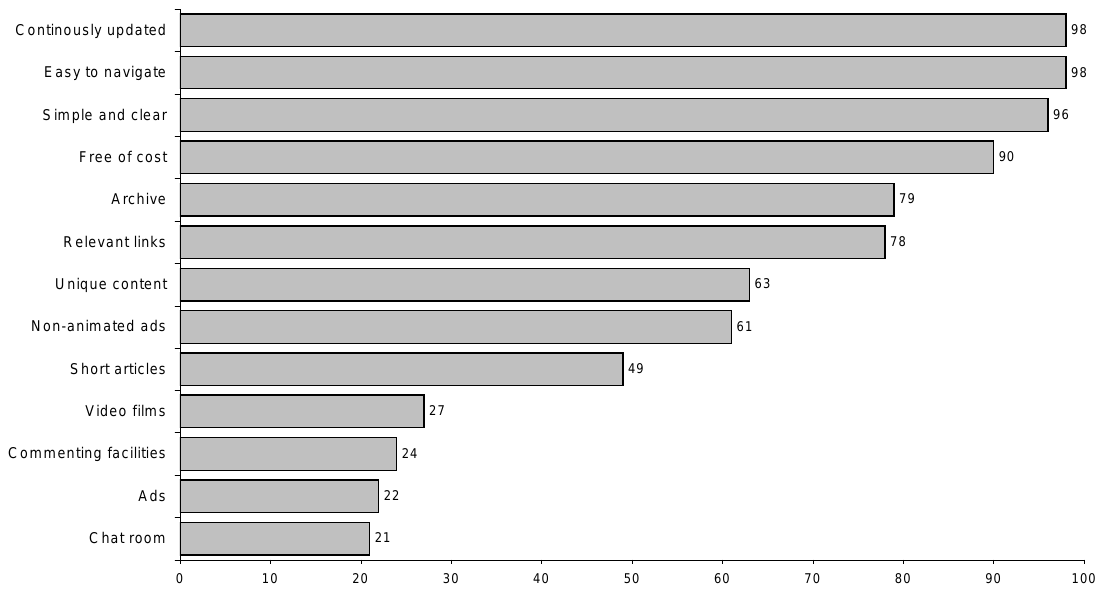
Figure 1: Important facilities on news sites on the Web